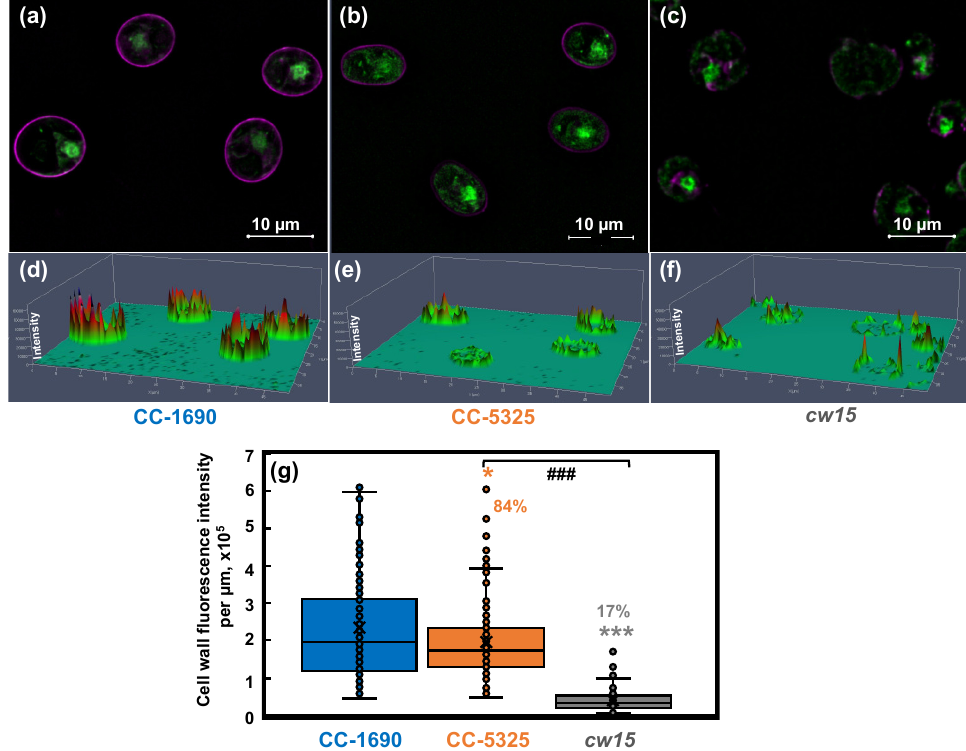
Figure 8. CC-5325 had intact cell wall which may be thinner than that in CC-1690. CC-1690, CC-5325, and cw15 cells were stained with Concanavalin A for cell wall imaging and Syto 13 TM Green Fluorescent Nucleic Acid to label the nucleus. cw15 , a cell-wall-deficient line, was used as a control. ( a – c ) Representative images for cell wall stain (magenta color) and nuclear stain (green color) for three different strains. ( d – f ) Cell wall fluorescence quantification; the scale for cell wall fluorescence intensity is in the vertical direction, taller peaks represent greater fluorescence intensity. ( a , d ), ( b , e ), ( c , f ): data for CC-1690, CC-5325, and cw15 , respectively. ( g ) Boxplot for cell wall fluorescence quantification. Total fluorescence intensity of each cell wall was normalized to the cell perimeter length. About 100 cells were quantified for each strain for fluorescence intensity. Statistical analyses were performed using a two-tailed t -test assuming unequal variance by comparing with CC-1690 (*, p < 0.05; ***, p < 0.001) or between CC-5325 and cw15 (###, p < 0.001). ( g ) The percentages of cell wall fluorescence intensity in CC-5325 and cw15 are relative to CC-1690.